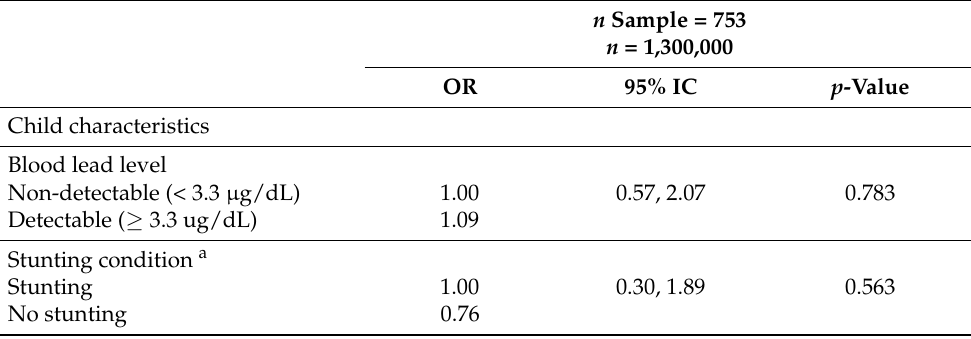
Table 4. Association between blood lead level and not being developmentally on-track according to